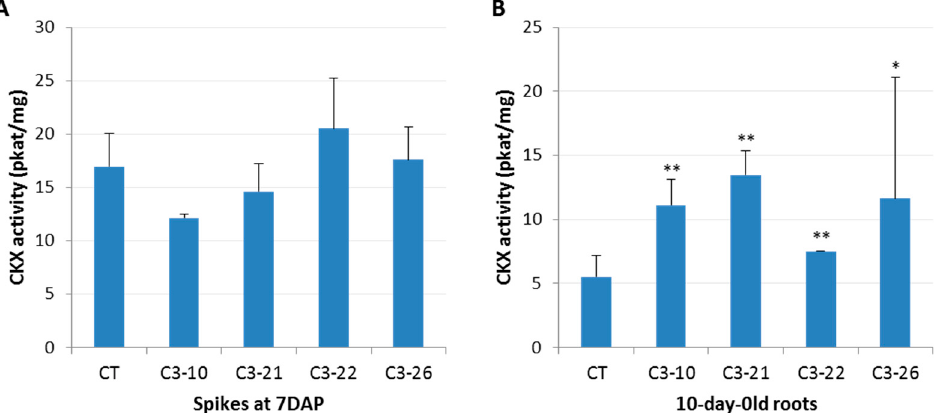
Figure 3. Enzymatic CKX activity (pkat/mg) in seven DAP spikes ( A ) and 10-day-old roots ( B ) of ckx3 mutant lines. CT, control plants. The activity assay was carried out for three to eight biological replicates, and two technical replicates were measured per sample significantly different from control at * p < 0.05, ** p < 0.01.